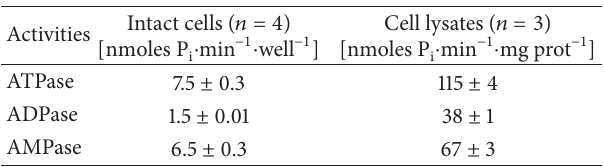
Table 2: Adenine nucleotide hydrolysis at the surface of HT-29 cells and protein